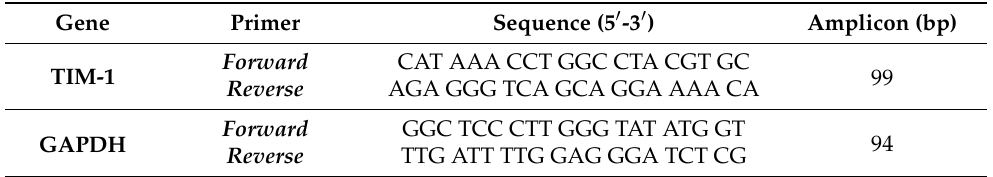
bp, base pairs; GAPDH, glyceraldehyde 3 ‐ phosphate dehydrogenase.